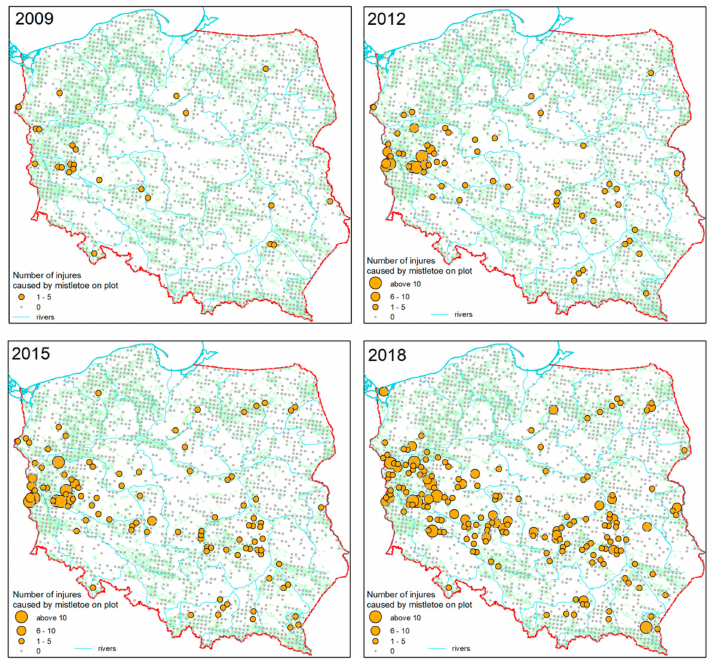
Figure 3. The occurrence of tree injuries caused by mistletoe on the forest monitoring level 1 plots in Poland in 2009, 2012, 2015, and in